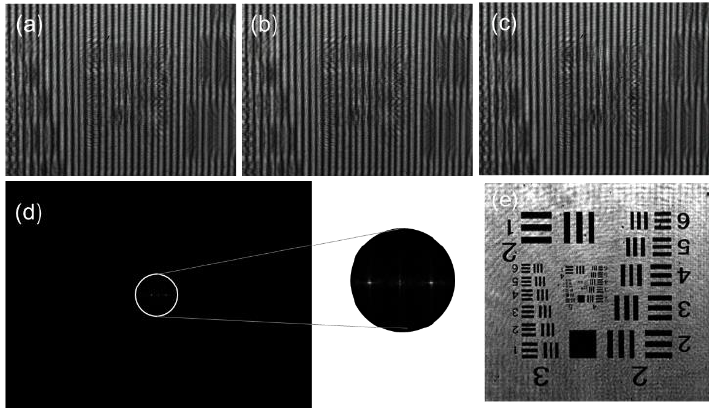
Figure 6. Optical results ( a ) I 1 , ( b ) I 2 , ( c ) I 3 , ( d ) spectrum of I 1 and ( e ) the reconstructed image.